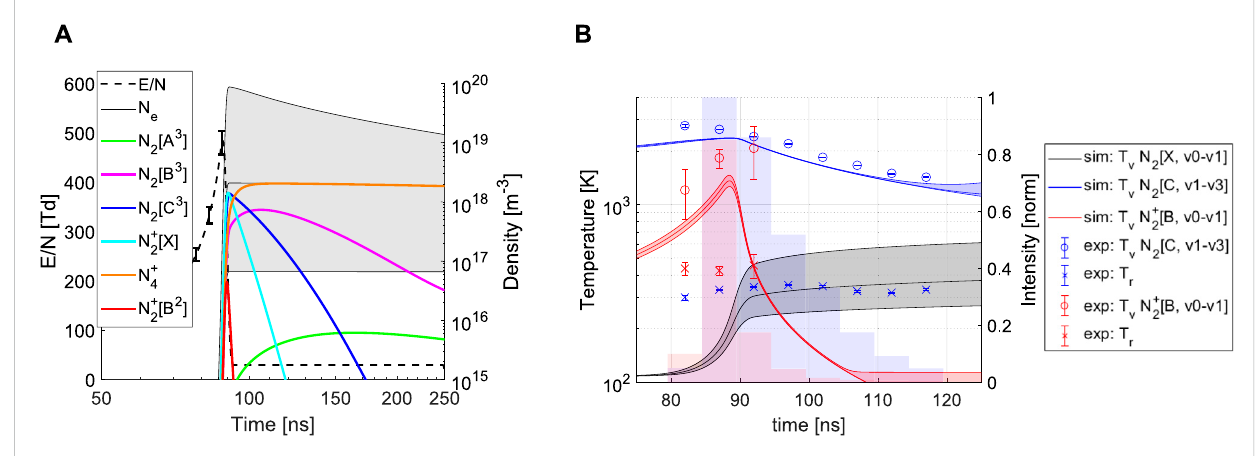
FIGURE 10 Global model results for pure nitrogen at 33 mbar. (A) Development of E / N and the density of some species of interest. The error bars for E / N and shadedregionfortheelectron densitydenotethe±5%runsofinput E / N (B) FittedSPSandFNStemperaturesofbothOESexperimentsandglobalmodel, plotted for the pure nitrogen 66 mbar E / N pulse over the axial center. The outer lines of the shaded regions show the ±5% runs of input E / N . The transparent bar plots show the total FNS and SPS emission and their temporal